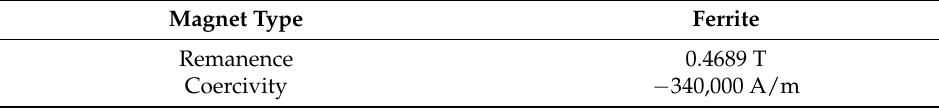
Table 2. PM (permanent magnet) specification.